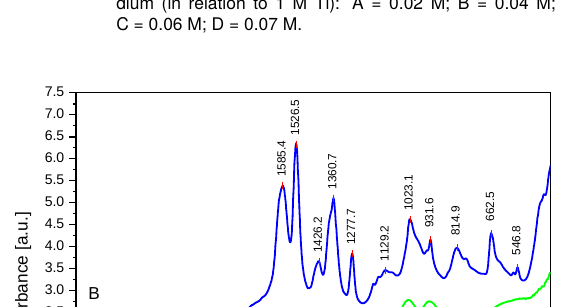
Absorption bands in the range 1585-1278 cm -1 are connected with acetyl acetone